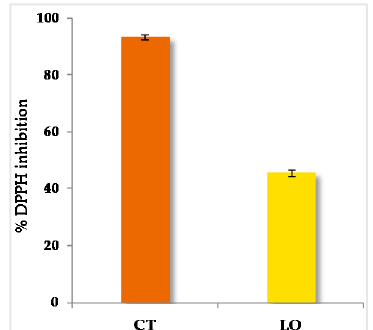
Figure 4. Mean values of antioxidant activity of the wine spirits aged in different kinds of wood (LO—Limousin oak; CT—chestnut). Adapted from [122].